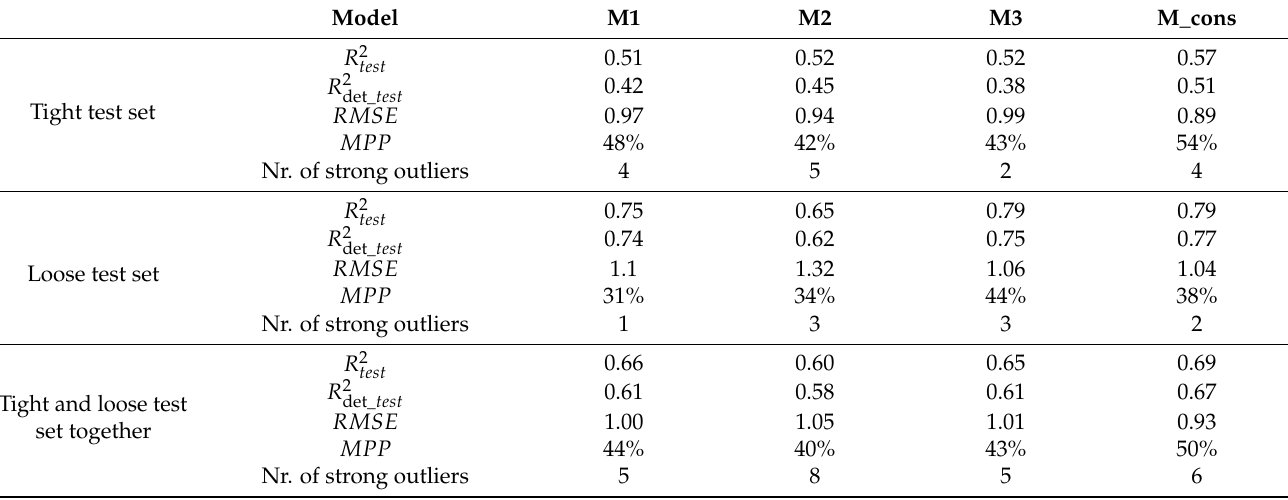
Table 2. Statistical parameters for the tight and loose test set predictions of models M1–M3. Model M1 M2 M3